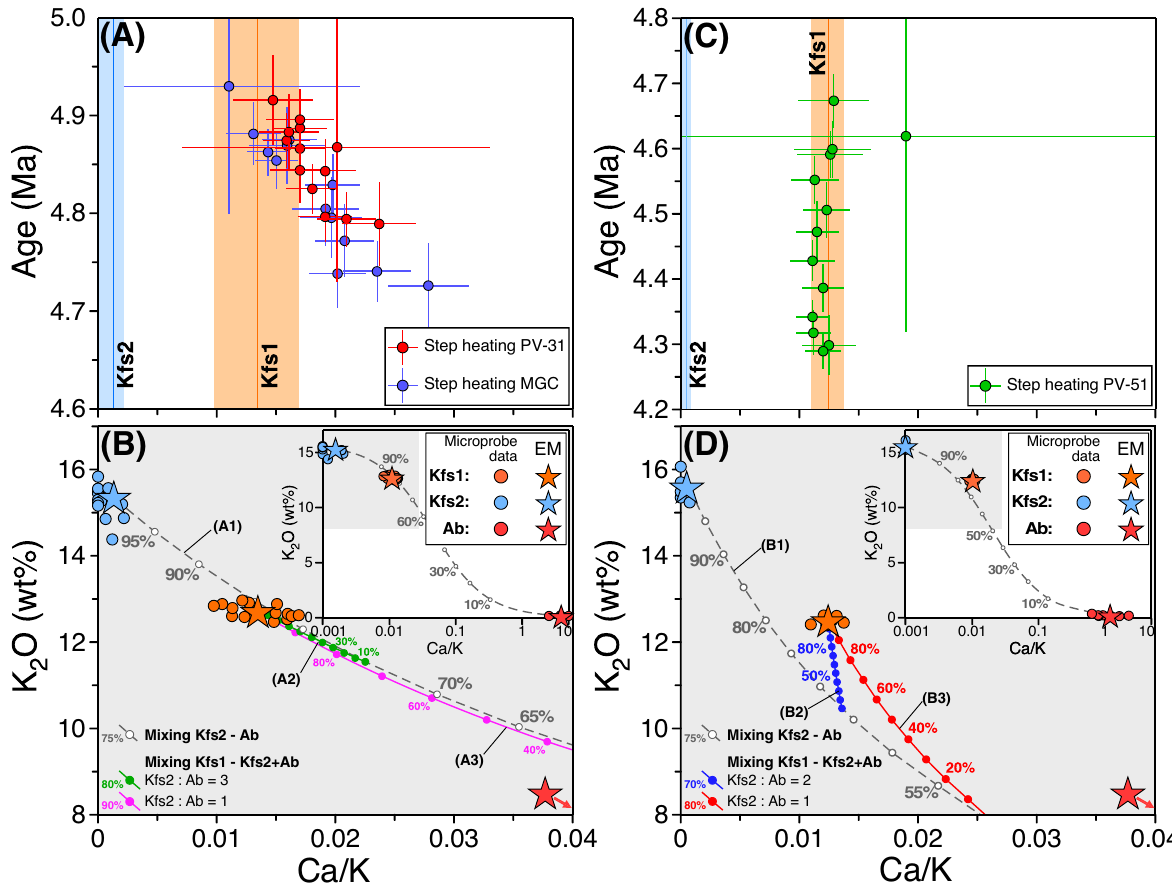
Figure 7. Three-isotope correlation diagram converted to age and elemental Ca/K ratio (derived from neutron- produced 37 Ar Ca and 39 Ar K ) for data from step-heating of mafic ( A ) and felsic ( B ) porphyry. K 2 O (wt %) vs. Ca/K (EMP data) of K-feldspar from mafic ( B ) and felsic ( D ) porphyries. The model lines in ( B ) and ( D ) show the effect of mixing secondary K-feldspar (Kfs2) and albite (Ab) with pristine K-feldspar (Kfs1). Model lines in ( B ): (A1) mixing between secondary K-feldspar and albite; (A2), mixing between pristine K-feldspar (Kfs1) with a mixture of secondary K-feldspar and albite in the proportion 3:1; (A3), mixing between pristine K-feldspar (Kfs1) with a mixture of secondary K-feldspar and albite in the proportion 1:1. Model line ( D ): (A1) mixing between secondary K-feldspar and albite; (B2), mixing between pristine K-feldspar (Kfs1) with a mixture of secondary K-feldspar and albite in the proportion 2:1; (B3): mixing between pristine K-feldspar (Kfs1)